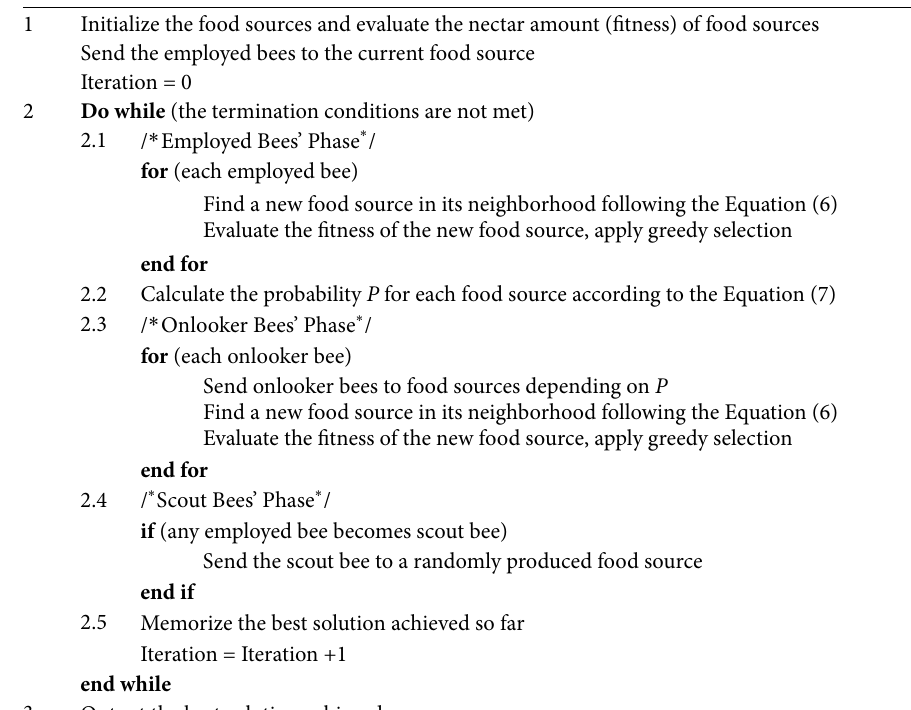
Table 2: Original ABC